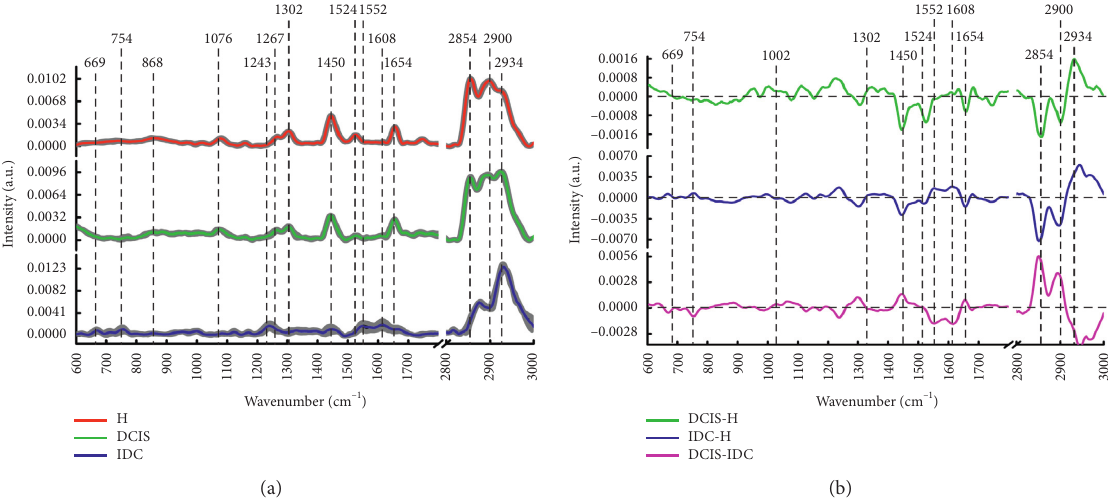
Figure 2: (a) The mean ± standard deviations (SD) of normalized spectra in H, DCIS, and IDC tissues; shading area represents standard deviations. (b) The differential spectra calculated from the normalized Raman spectra among different tissues.